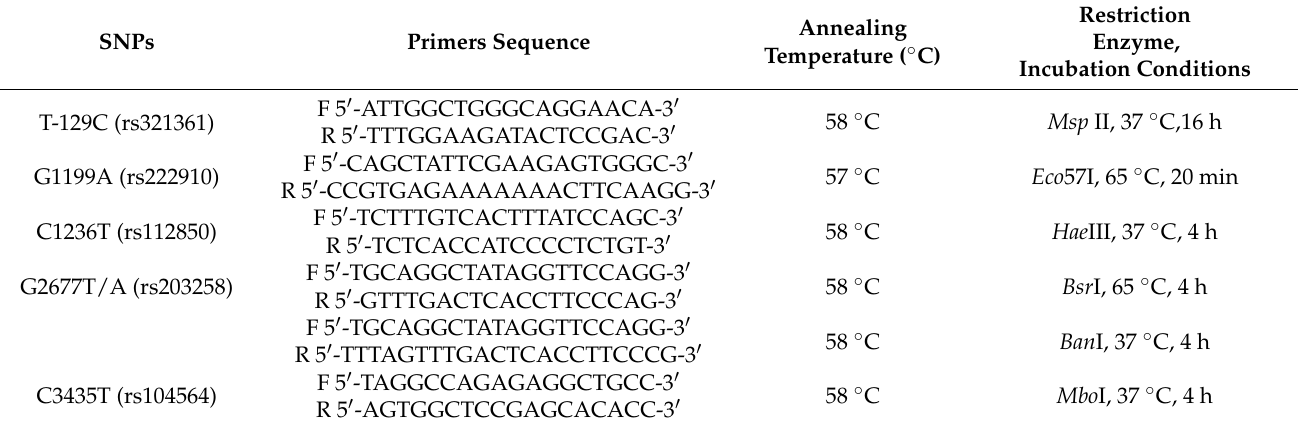
Table 3. List of SNPs, primer sequences, type of enzymes used for PCR-RFLP analysis in this